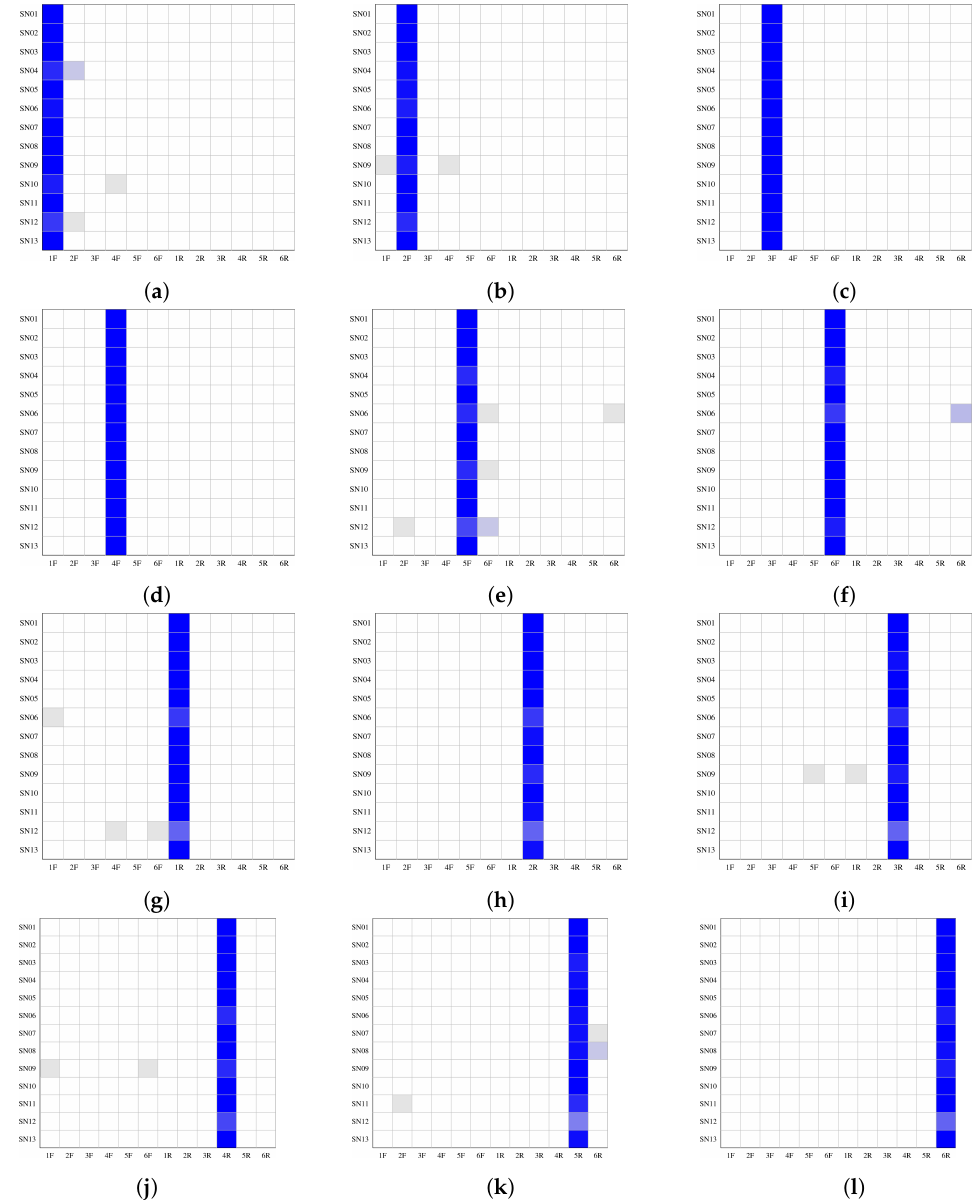
Figure 6. Intra -layer user profile linking results: each graph groups the results of a single source on all thirteen SNs, six for the front cameras ( a – f ) and six for the rear cameras ( g – l ); the number of images in each cell is identified through a white-to-blue scale, from 0 (white) to 17